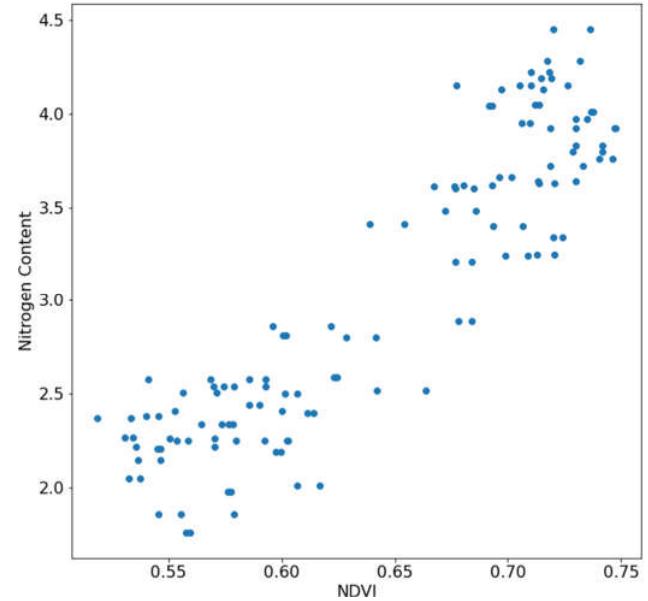
Figure 6. Linear relationship between nitrogen content and the mean NDVI.